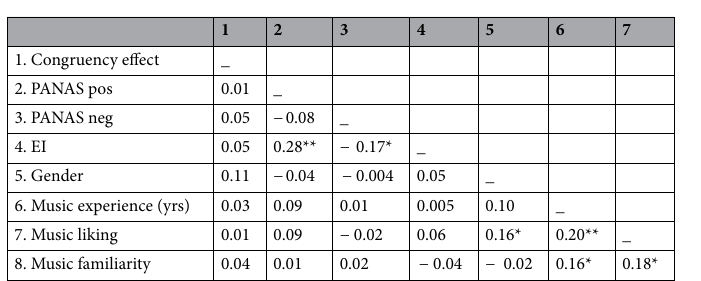
Table 1. Correlations between the emotion-congruency effect and individual variables. Congruency effect is computed as the difference between the accuracy ( d ′ ) for congruent pictures and incongruent pictures. * p > .05; ** p >